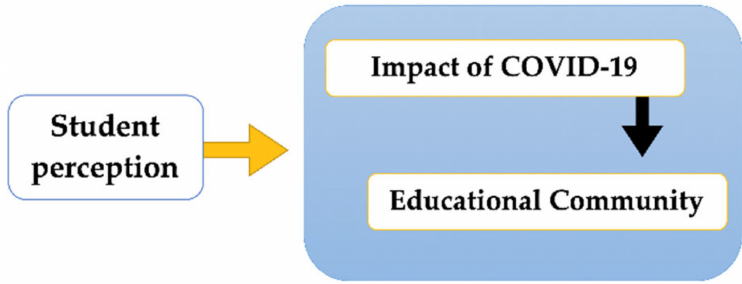
Figure 1. Research purpose. Self-made